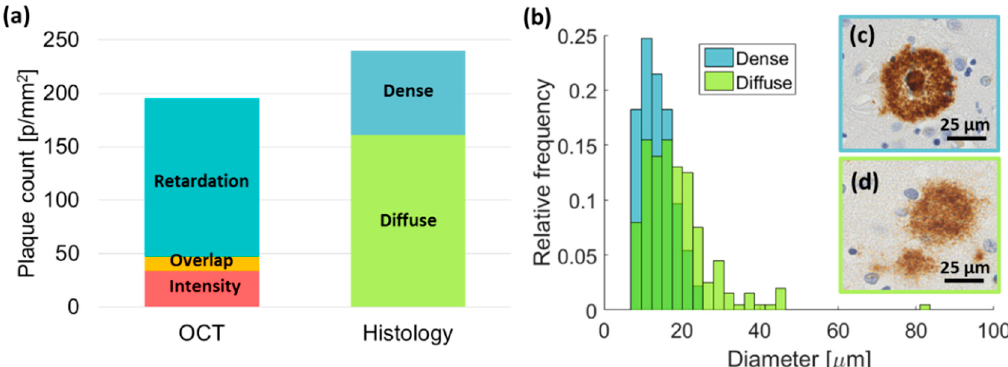
Figure 7. Comparison of histology and OCT data. ( a ) Absolute plaque count (p/mm 2 ) in retardation and intensity data including those which overlap, compared to diffuse and dense plaques in histology. ( b ) Histogram of the plaque diameter in dense (4.8–25.5 µm) and diffuse plaques (6.9–83.6 µ m) evaluated in histological slices. ( c ) A typical image of a dense plaque. (d) A typical image of a di ff use